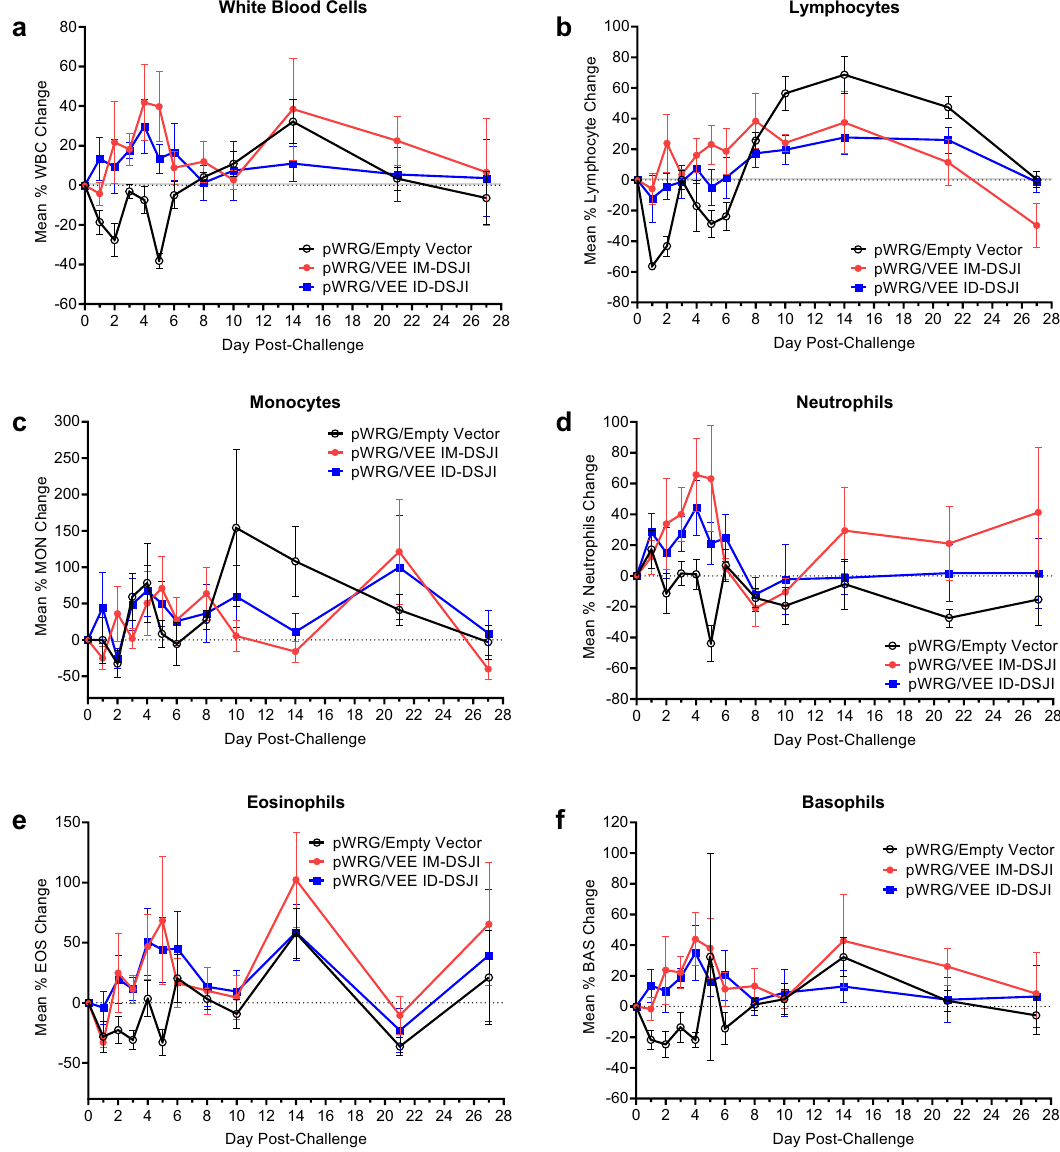
Fig. 6 VEEV DNA vaccine delivered by IM- or ID-DSJI prevents decline in white blood cell populations following aerosol challenge. Percent change from baseline in ( a ) white blood cells, ( b ) circulating lymphocyte populations, ( c ) circulating monocyte populations, ( d ) circulating neutrophil populations, ( e ) circulating eosinophil populations, and ( f ) circulating basophil populations following aerosol VEEV exposure. The dashed line represents the baseline values as determined by the average of 3 independent measurements on days − 7, − 5, and − 3 relative to challenge. Data represent the group mean ± SEM. Group and pairwise statistical analysis is presented in Supplementary Table tracheobronchial lymph node tissue produced no signi fi cant fi ndings. Viral antigen could not be detected by immunohisto-